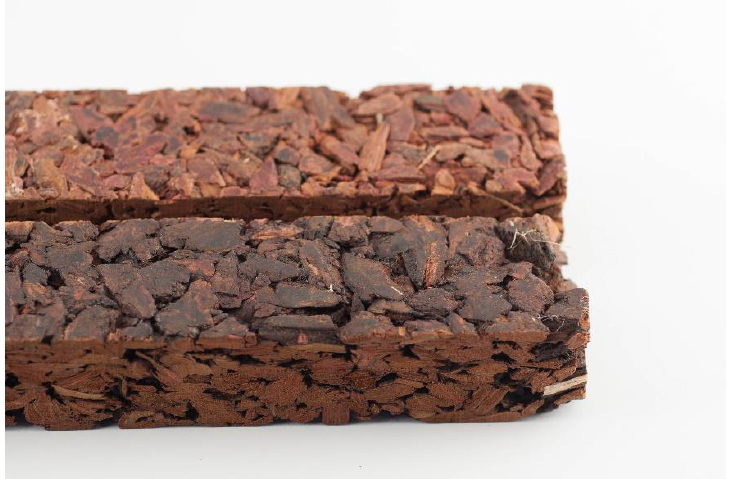
Figure 1. Larch bark insulation panel (glued with tannin in the foreground and UF in the background (thickness = 20 mm, density = 400 kg/m³).